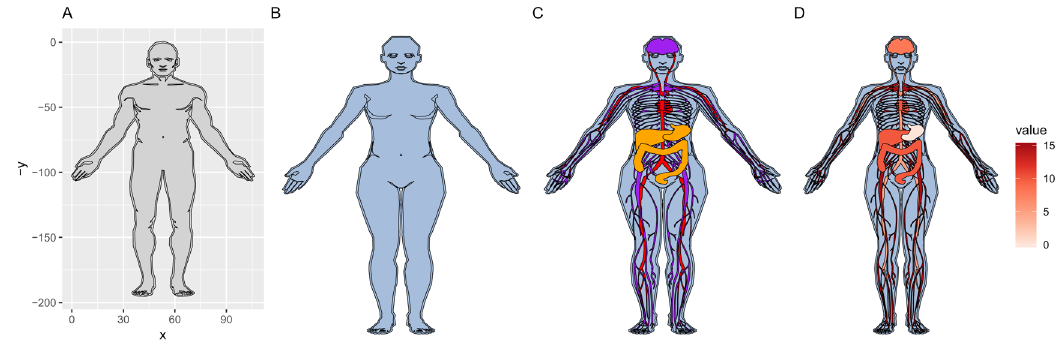
Figure 2. ( A ) Default plot generated by calling gganatogram(), ( B ) adding female, plotting specified organs by ( C ) colour, ( D )